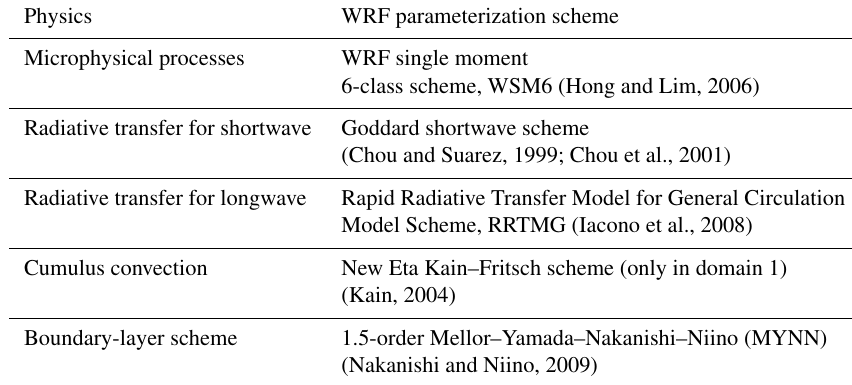
Table 1. Physics settings used in WRF simulations.